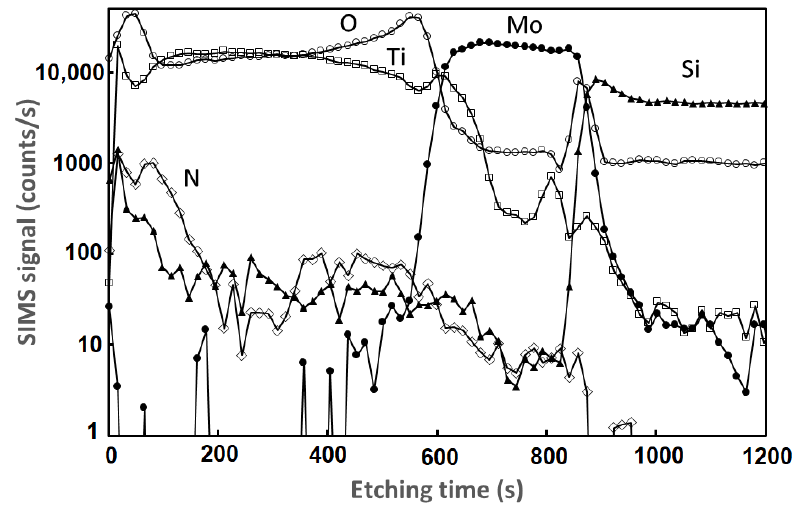
Figure 6. SIMS depth profiles of Mo–Ti bilayer film heated at 400 ◦ C and exposed to (Ar-31%N 2 -6%H 2 ) plasma for 1 h.